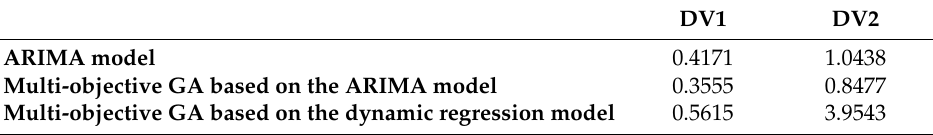
Table 2. The deviation averages for the material cost object for every